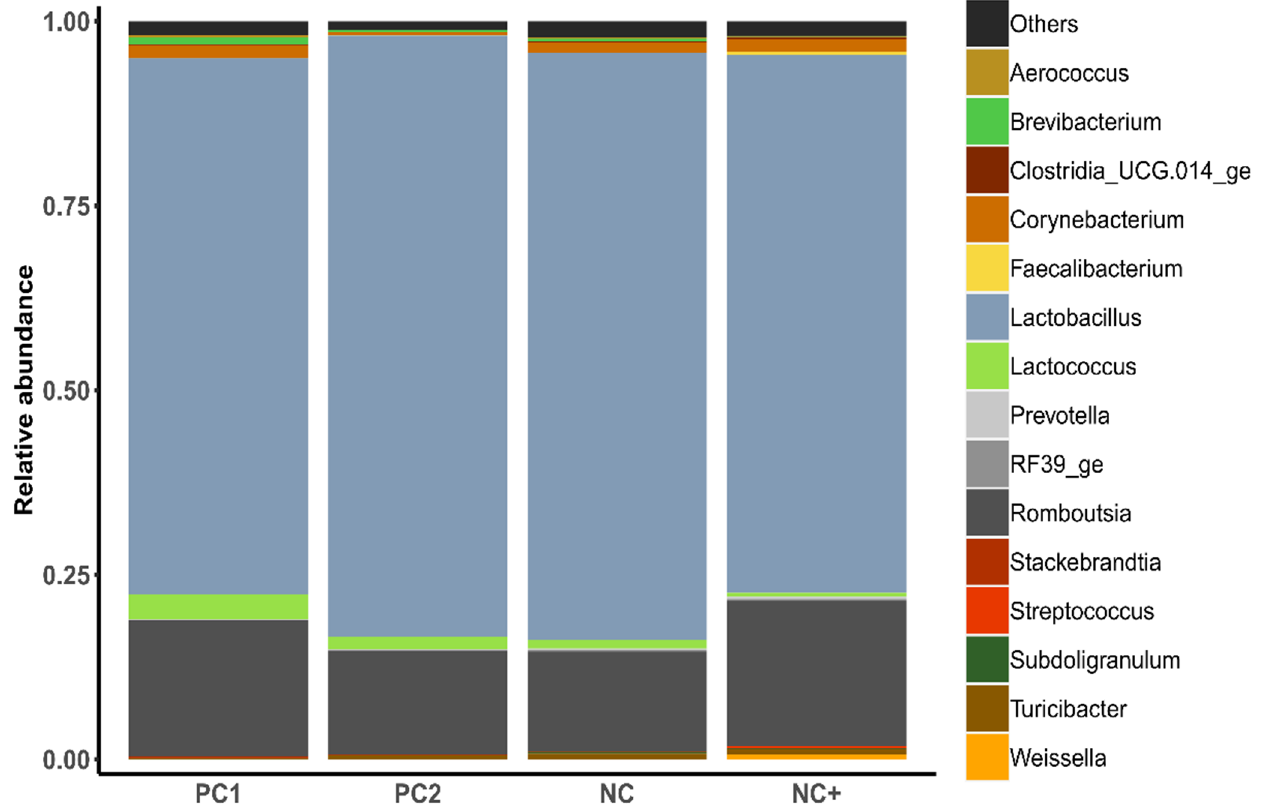
Figure 1. The relative abundance of various microbes in the jejunum of broilers offered the different experimental diets. Table 6. Differences in the relative abundance of genera in the jejunal digesta of broilers offered different experimental